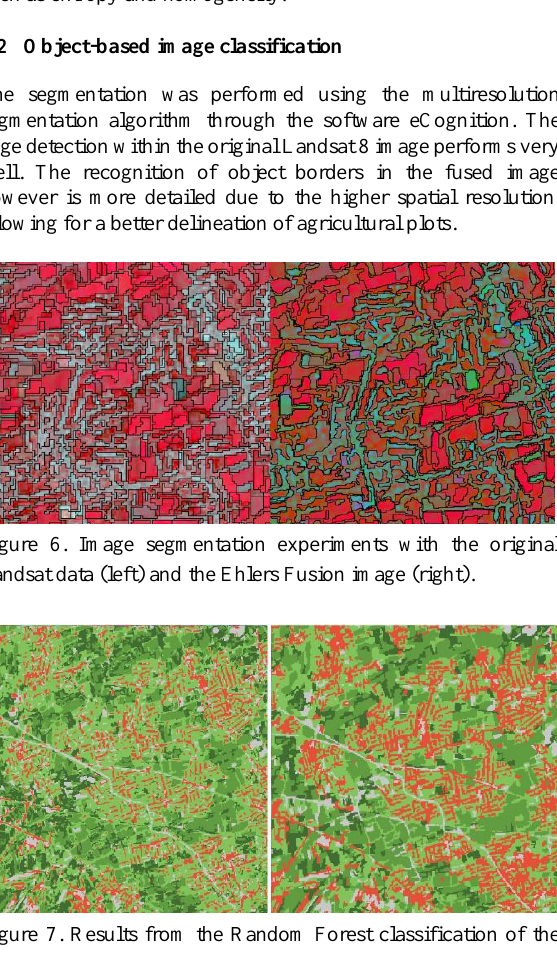
Table 6. Mean Bias comparison between the Ehlers and GS fusion method with the GS scoring best.